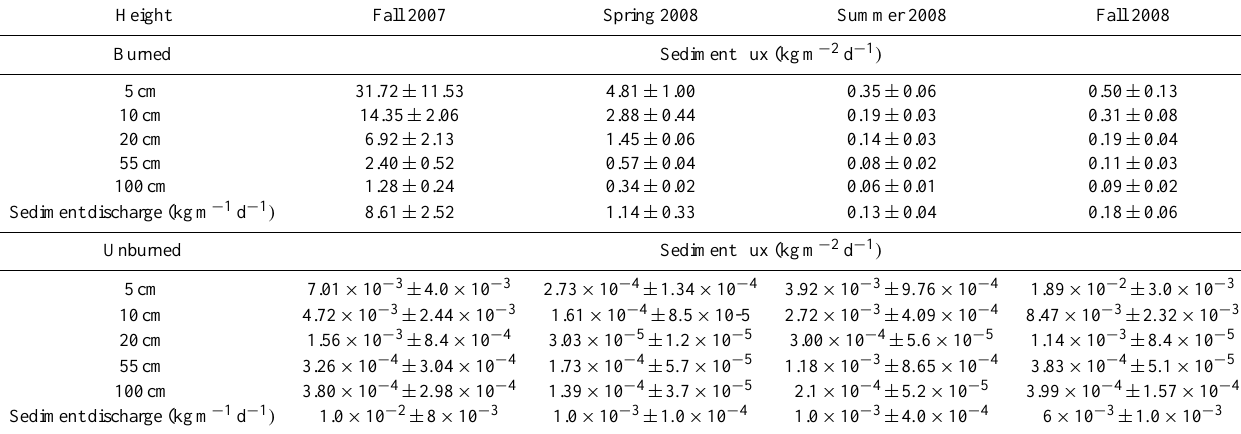
Table A1. Mean ( ± SE) sediment flux (kgm − 2 d − 1 ) from BSNE collectors located at different heights (0.05, 0.10, 0.20, 0.55 and 1.0m) in the recently burned and adjacent unburned area. Mean sediment flux was plotted as a function of sample height for each sampling date, and a power model was fitted to each plot to calculate sediment discharge (kgm − 1 d − 1 ) as described in Van Donk et al. (2003).